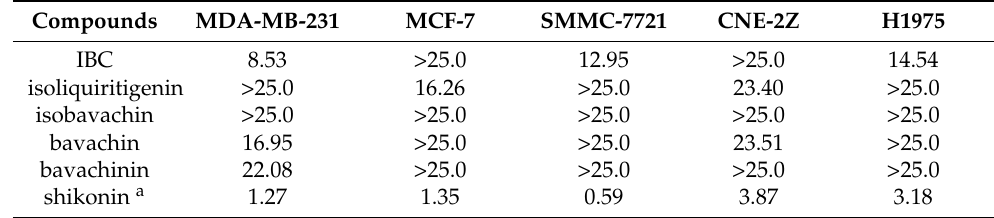
Table 1. Cytotoxic activity (IC 50 , 72 h) for IBC and its analogs against five cancer cell lines.